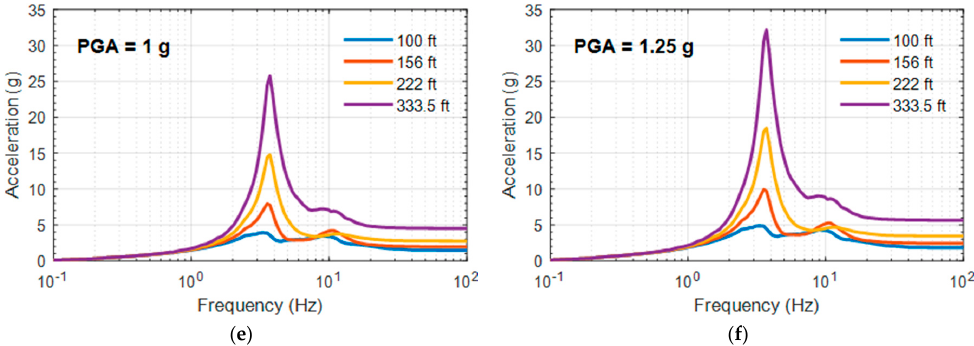
Figure 11. FRS of a non-isolated reactor containment building (RCB) at various peak ground acceleration (PGA) levels: ( a ) PGA = 0.2 g; ( b ) PGA = 0.3 g; ( c ) PGA = 0.5 g; ( d ) PGA = 0.75 g; ( e ) PGA = 1 g; ( f ) PGA = 1.25 g.